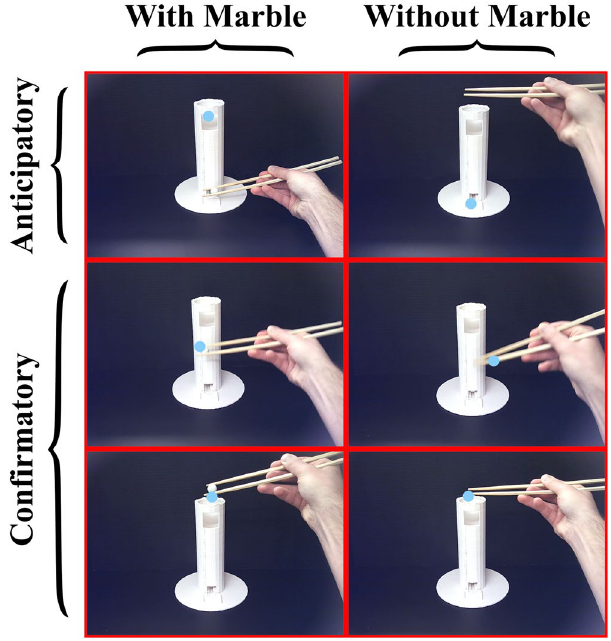
Figure 1. Examples of Visual Strategies – Anticipatory visual strategies were those where the vertical distance between the fixation point and the chopsticks tip was > 36 mm. Confirmatory visual strategies were those where the vertical distance between the fixation point and the chopsticks tip was ≤ 36 mm. Visual strategies occurring while transporting the marble to the apex of the cylinder (with marble) were differentiated from those occurring after successfully dropping the marble into the cylinder and returning the chopsticks to the base of the cylinder (without marble). Blue dot = fixation